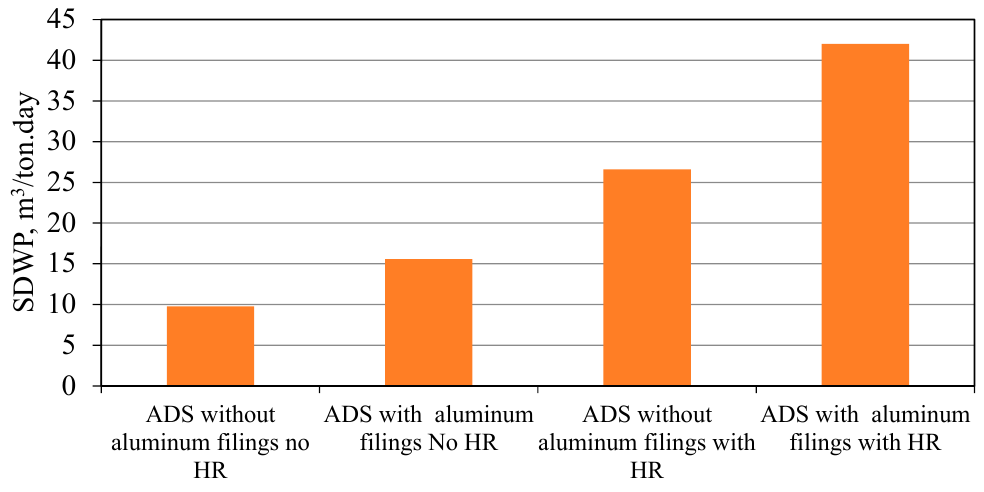
◦ C driving temperature with and without aluminum filings with and without Figure 5. SDWP at 95°C driving temperature with and without aluminum filings with and without heat recovery. Figure 5. SDWP at 95 heat